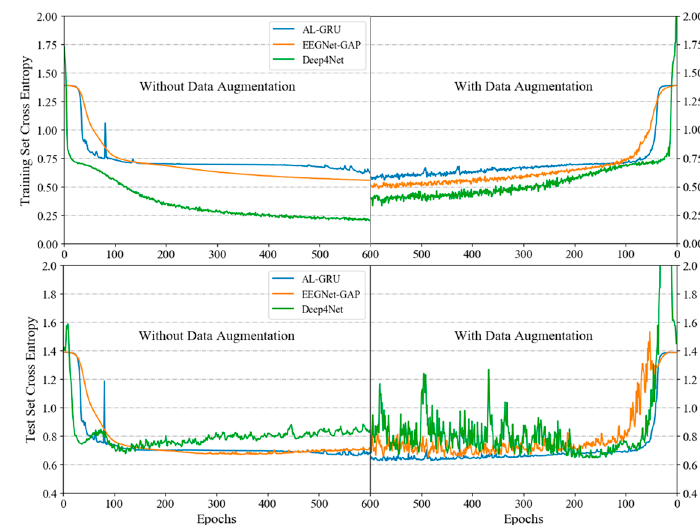
Figure 9. The optimization learning curves for models over 600 epochs.